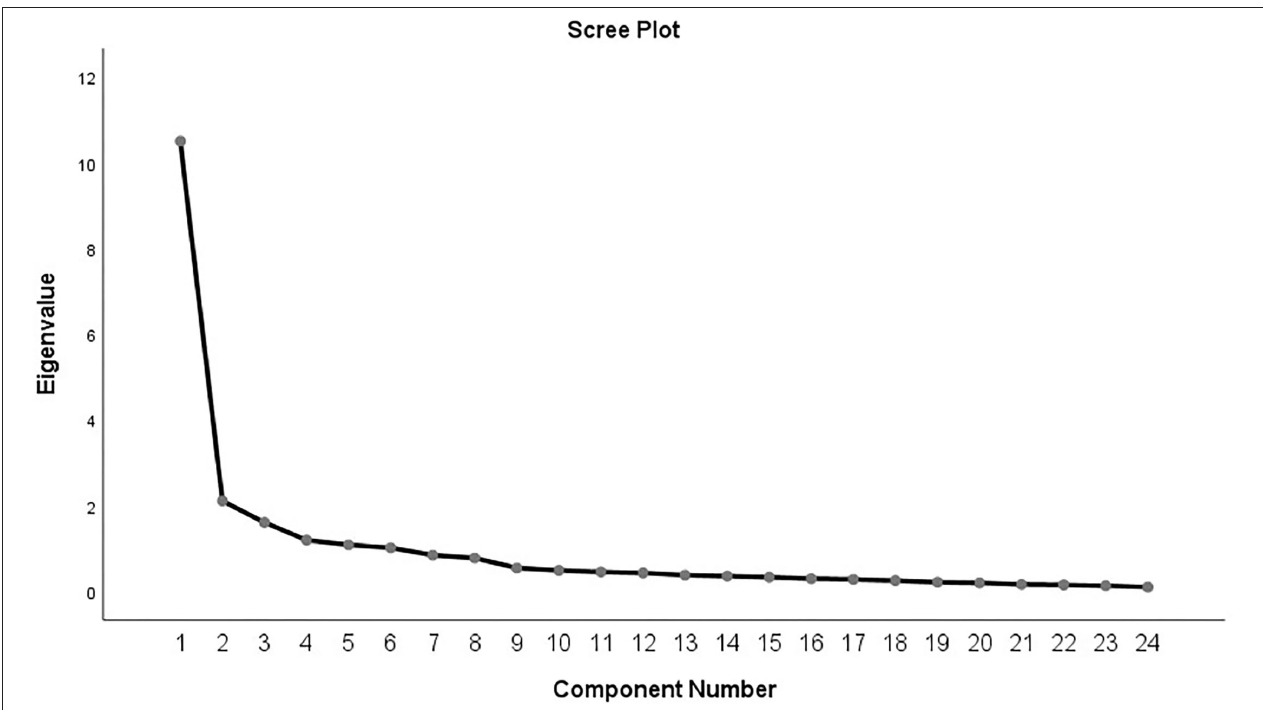
FIGURE 1 | The scree plot of the items related to stigma toward epilepsy in normal people. The scree plot was acquired by principal component analysis (PCA) with correlation matrix.